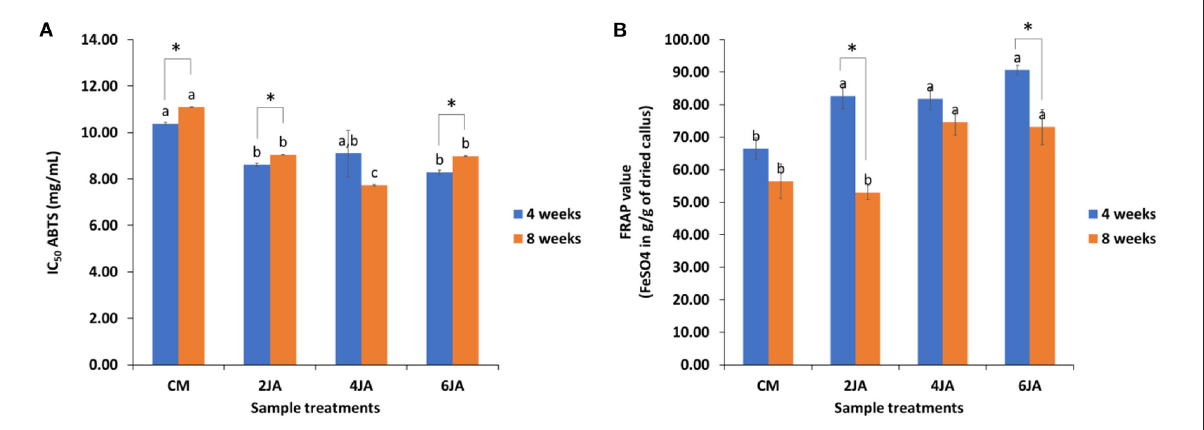
FIGURE4 Effect of different concentration of jasmonic acid on (A) ABTS radical scavenging activity, and (B) FRAP reducing potential in 4 and 8-week-old A. indica green callus. Data expressed as mean values ± standard error (SE) of three replicates. Treatment bars denoted with different letters (subject to samples’ age) are significantly different at p ≤ 0.05 according to Duncan’s multiple range test (DMRT), while * denotes significant difference between samples’ age (at p < 0.05) according to Student’s t -test. CM , callus induction media composed of 0.6 mg/L TDZ; TDZ , thidiazuron; JA , jasmonic acid.